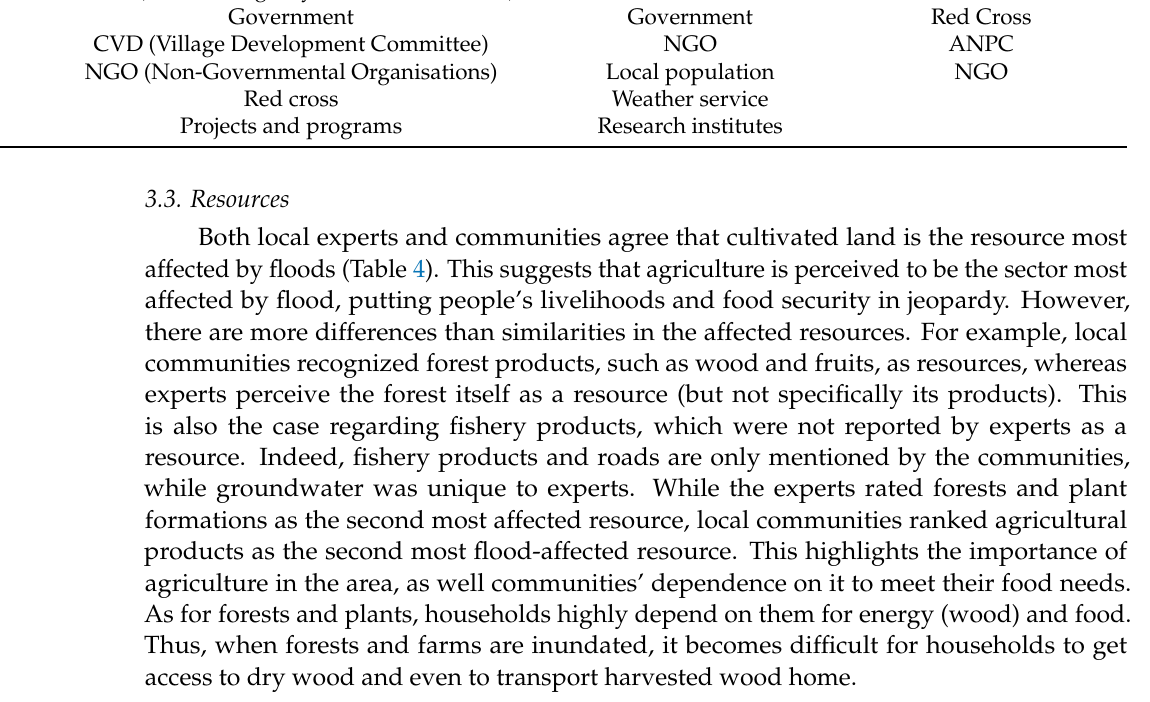
Table 4. Ranking of resources according to experts and local communities.